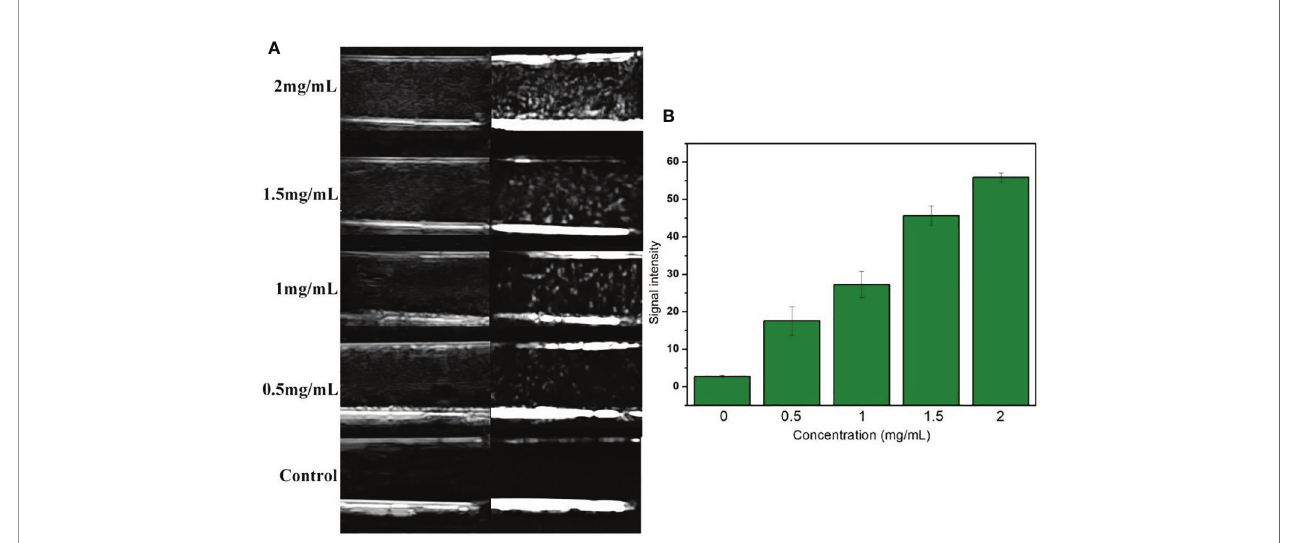
FIGURE 2 | (A) US images of VEGFR2-PEG-HSNs-Fe with different concentrations; (B) signal intensity of VEGFR2-PEG-HSNs-Fe with different concentrations in CEUS mode.